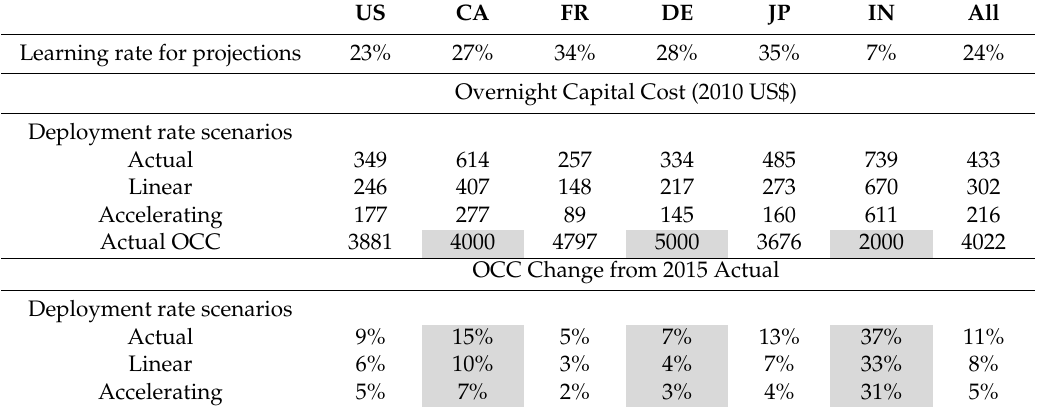
Table 3. Projected 2015 OCC by country for the three deployment rate scenarios at the projected pre-reversal learning rates. Actual OCC [20] for comparison. Percentage change of projected OCC compared with actual OCC. US CA FR